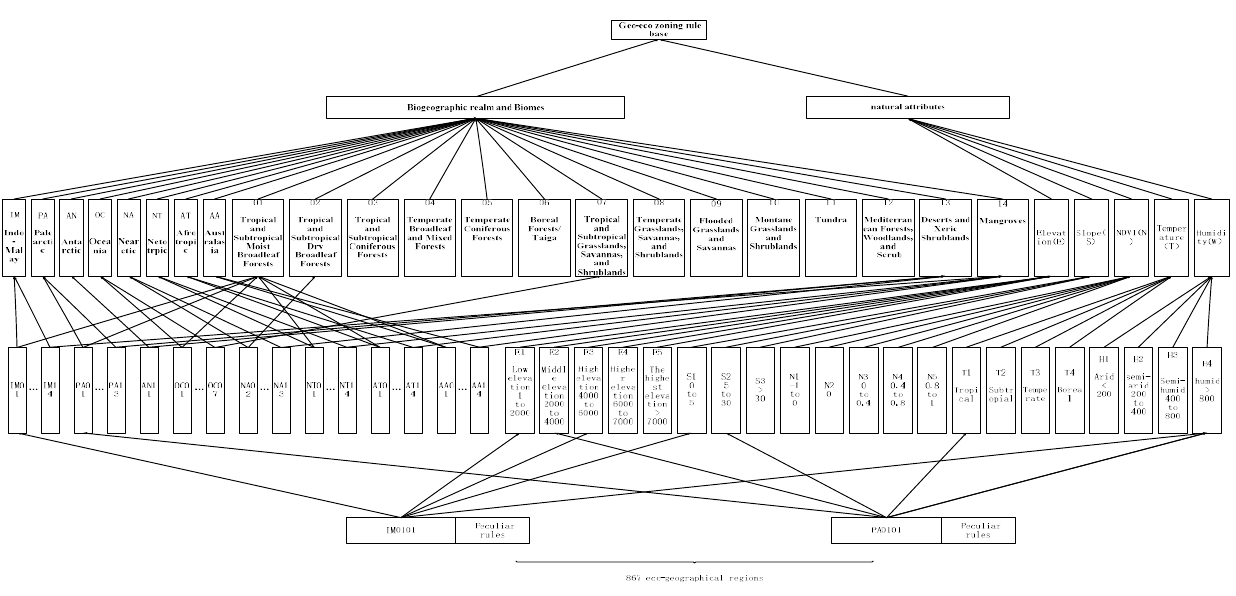
Fig. 2 Geo-eco zoning rule database table in the object-relational database. A simple spurious change expression is designed. Spurious change rule representation uses a six-digit code, namely, “XXXXXX”, where the first three digits represent the land cover class of the early phase image and the last three digits represent the class code of the new image. The first class code of GlobeLand30 land cover product was used in this study. The specific spurious change rules must be determined based on the expert knowledge of remote sensing interpreters and geographical